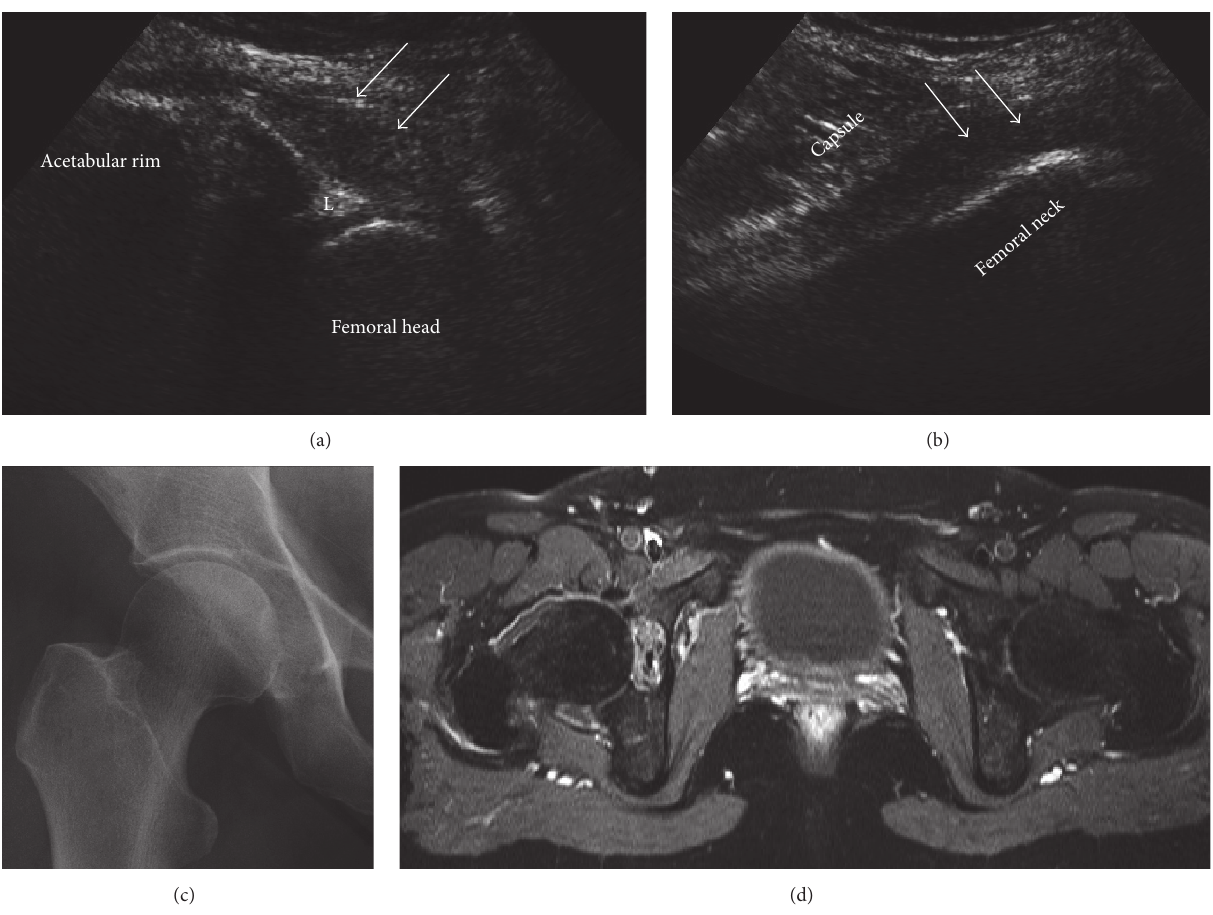
Figure 1: Diagnostic path for patient #4, a 55-year-old woman with a 3-day history of acute pain in the right hip. Ultrasound scans revealed an intra-articular effusion (white arrows; L = labrum) with distension of the capsule (a, b) whereas the radiograph was unremarkable. T2 weighted MRI scans (d) confirmed effusion in the right hip and ruled out extra-articular abscess formation and advanced osteochondral involvement.